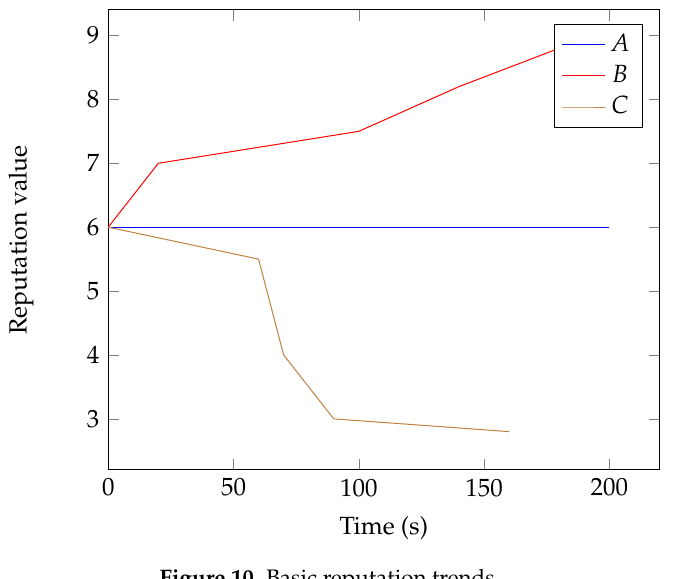
Figure 10. Basic reputation trends.